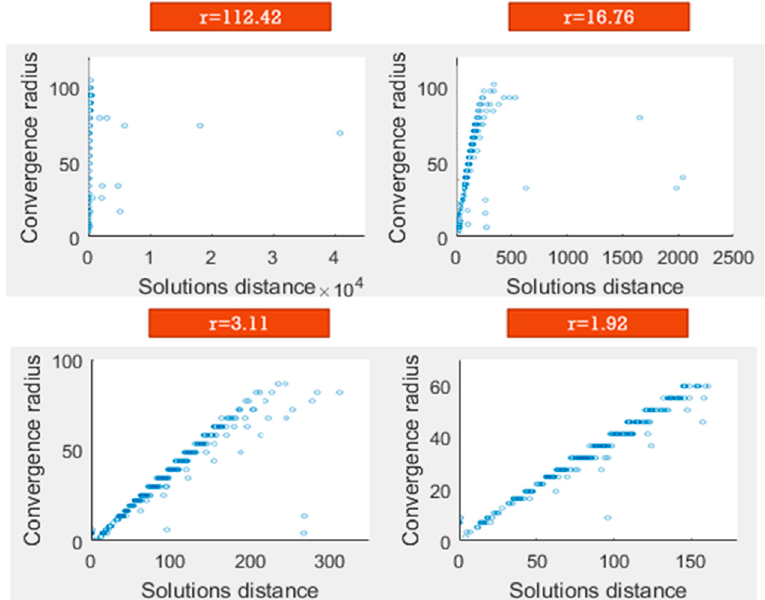
Figure 4. Sequential reduction of the r-correlation factor. The outliers are removed with this iteration process. The remaining distribution (r = 1.92) does not present outliers.